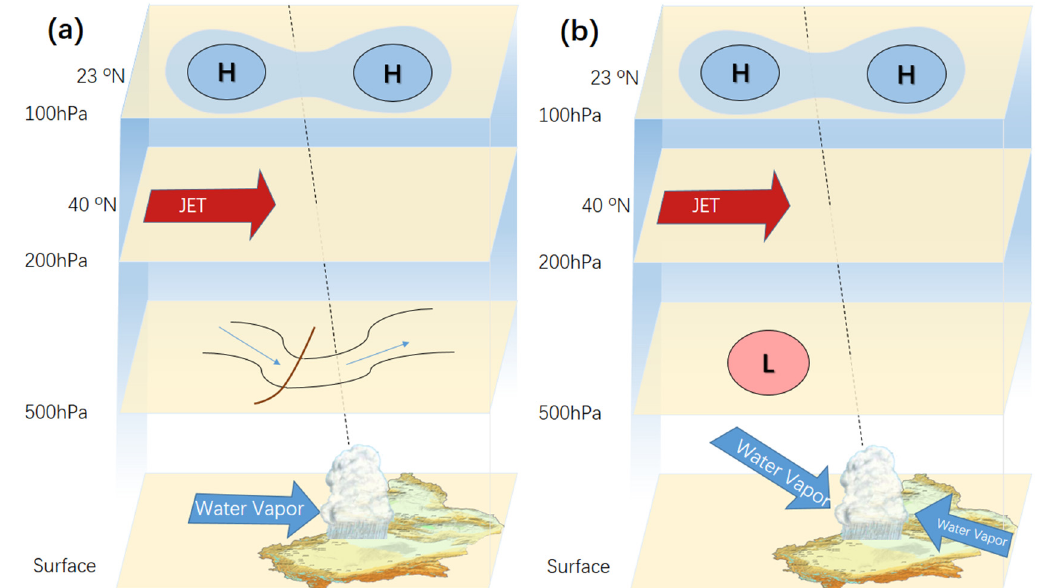
Figure 12. Conceptual model of ( a ) Type WT1 and ( b ) WT2. “H” represents the center of the high pressure. “L” represents the center of the low pressure. The black line represents the isobaric line. The brown line represents the trough line. The narrow blue arrow represents air flow. The latitudes on the left indicate the averaged location of the system on that level. The dotted black line represents the location of rainfall on the different levels.